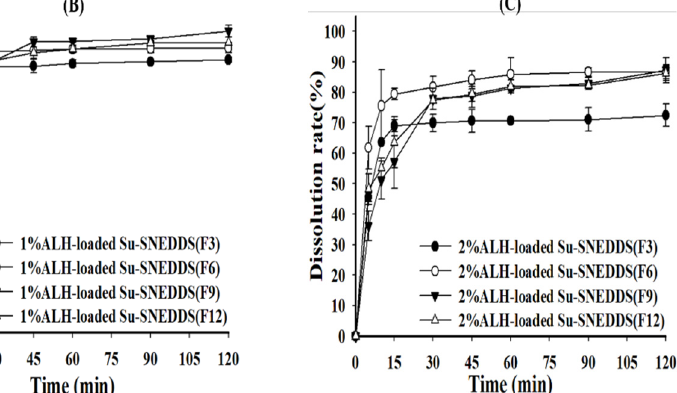
Figure 4. Dissolution profiles of raw ALH ( A ), 0.5% ALH-loaded SNEDDS ( A ) and Su-SNEDDS ( B ), 1% ALH-loaded; (( C ) 2% ALH-loaded) prepared from F3, F6, F9, F12 in pH 1.2 buffer. Vehicle composition F3, F6, F9, and F12 are from Table 2.